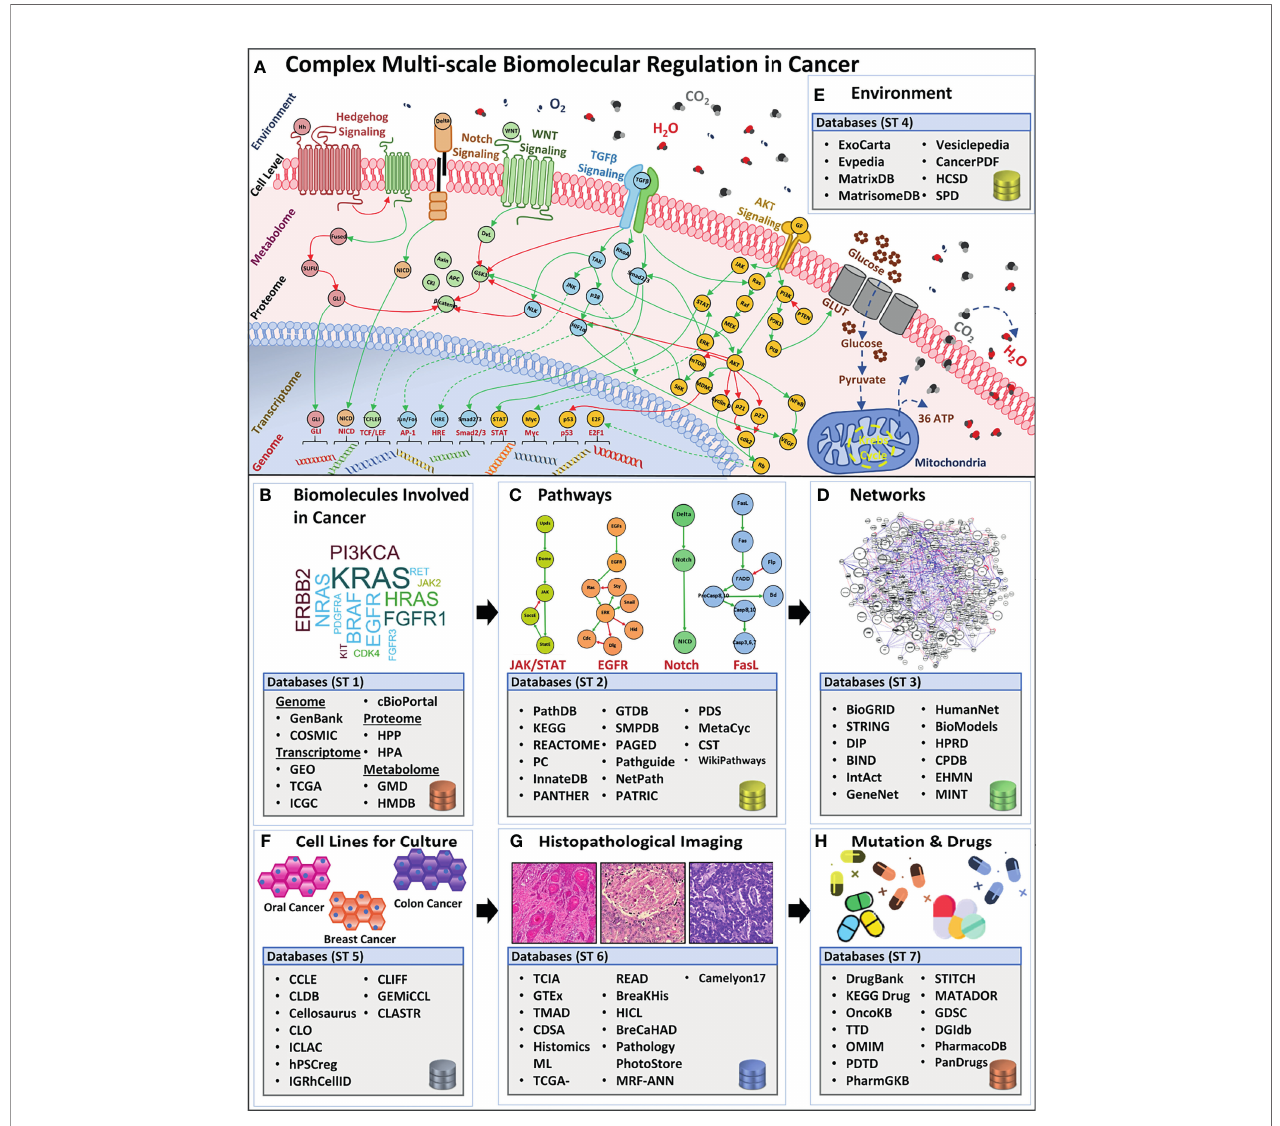
FIGURE 1 | Overview of complex biomolecular regulation in cancer and scale-speci fi c databases. (A) The complexity between genomic, transcriptomic, proteomic, metabolomic, cell-level, and environmental levels in a cancerous cell. Four examples of biomolecular signaling pathways are listed e.g., Hedgehog, Notch, (Wingless) Wnt, TGF b , and AKT pathway. Stimuli from the extracellular environment signal the downstream pathway activation, in the cell, towards alternating the regulations in the proteomic, metabolomic, transcriptomic, and genomic scales, bringing out a system-level outcome in cancers. Lists (B) biomolecule (genes, transcripts, proteins, and metabolites) databases such as GenBank, GEO, TCGA, HPP, HMDB, etc. (C) Pathways databases such as PathDB, KEGG, STRING, etc. (D) Networks databases such as BioGRID, DIP, BIND, etc. (E) Environment databases e.g, ExoCarta, MatrixDB, MatrisomeDB, etc. (F) Cell lines databases such as CCLE, CLDB, Cellosaurus, etc. (G) Histopathological image database, for instance, TCIA, GTEx, TMAD, etc., and (H) Mutation and drug databases such as DrugBank, KEGG Drug, OncoKB,